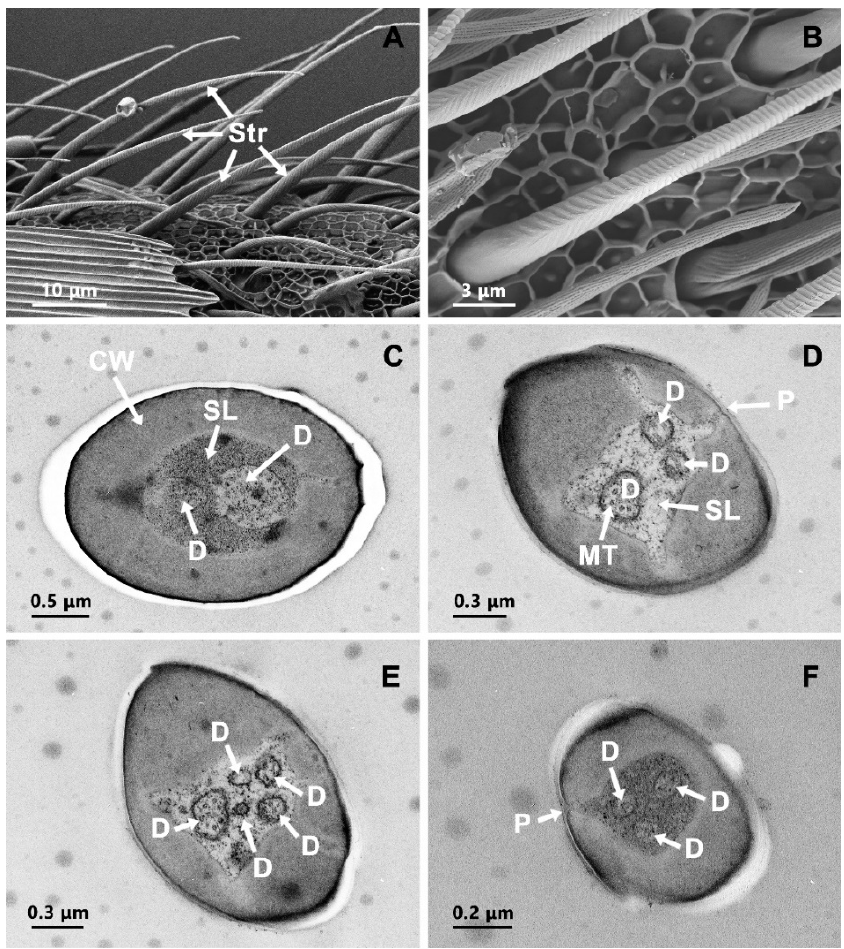
Figure 3. Scanning electron micrographs and transmission electron micrographs of sensilla trichodea (Str). ( A ) Distribution pattern of Str; ( B ) the surface structure of Str; ( C ) transverse section through the basal section of Str; ( D , E ) transverse section through the middle part of Str; ( F ) transverse section through the distal part of Str. CW: cuticle wall; D: dendrite; MT: microtubule; SL: sensilla lymph; P: